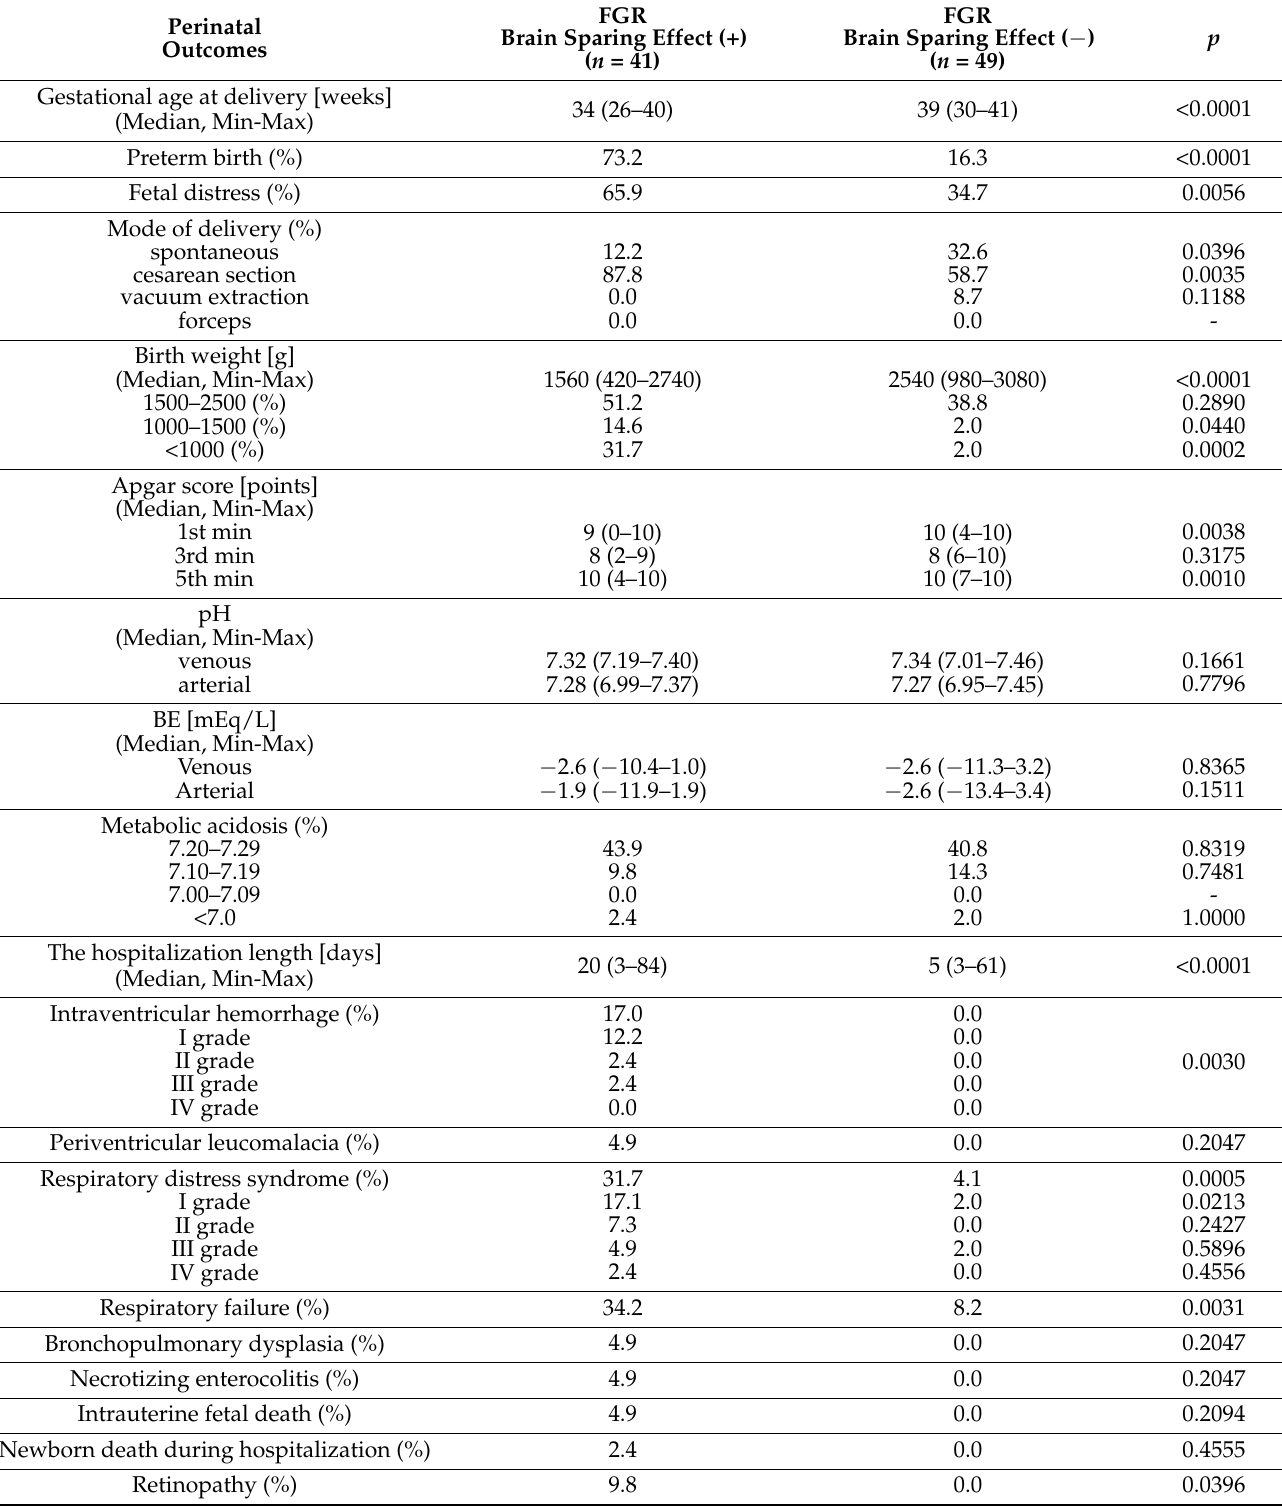
Table 5. Perinatal outcomes of the growth-restricted fetuses with the presence or absence of the brain sparing